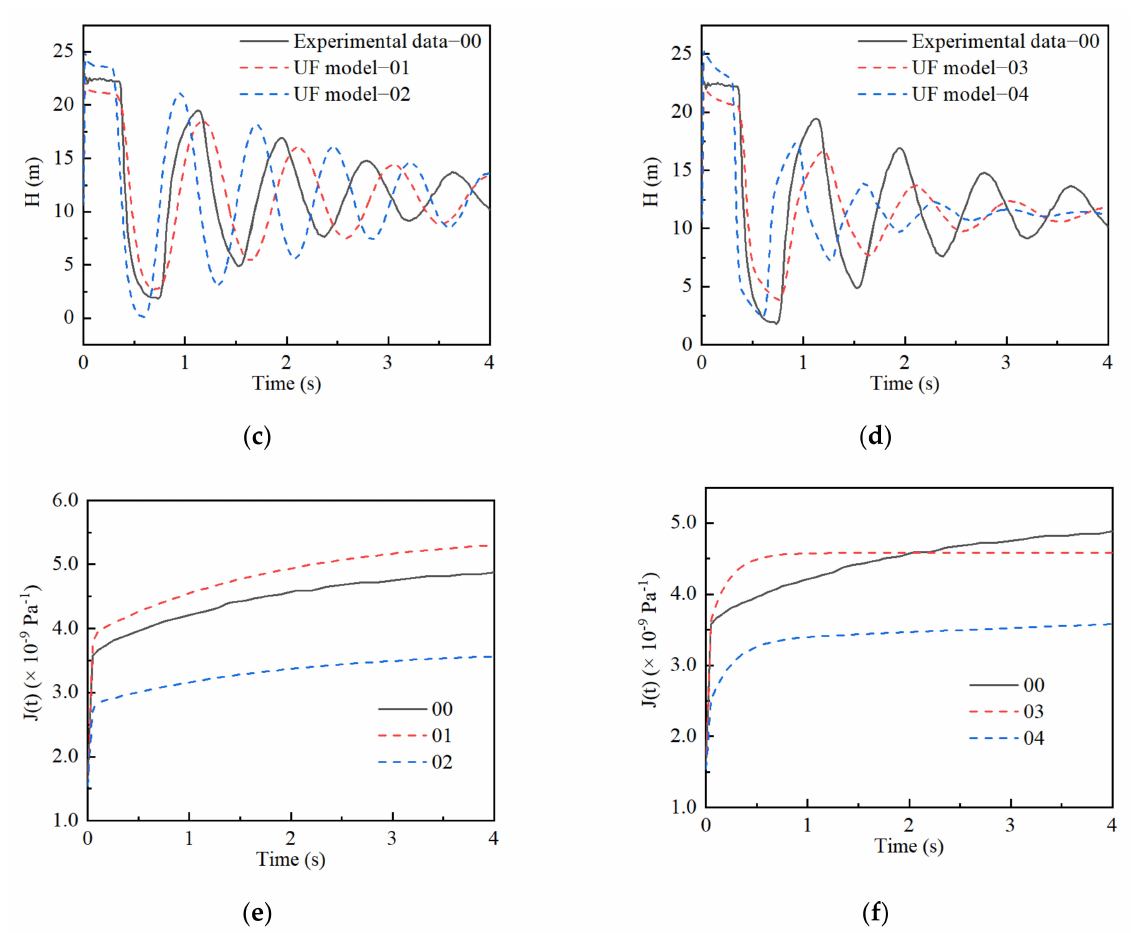
Figure 7. Pressure head and creep function: ( a ) Test A of QF model; ( b ) Test B of QF model; ( c ) Test A of UF model; ( d ) Test B of UF model; ( e ) Creep function of Test A; ( f ) Creep function of Test